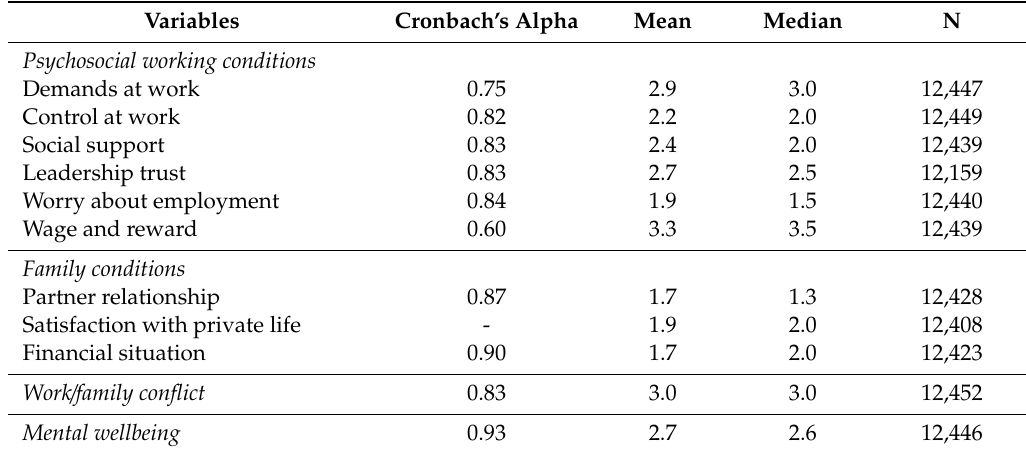
Table 2. Mean values of variables measuring psychosocial working conditions, family conditions, work / family conflict and mental wellbeing (1 = good conditions—5 = bad conditions).